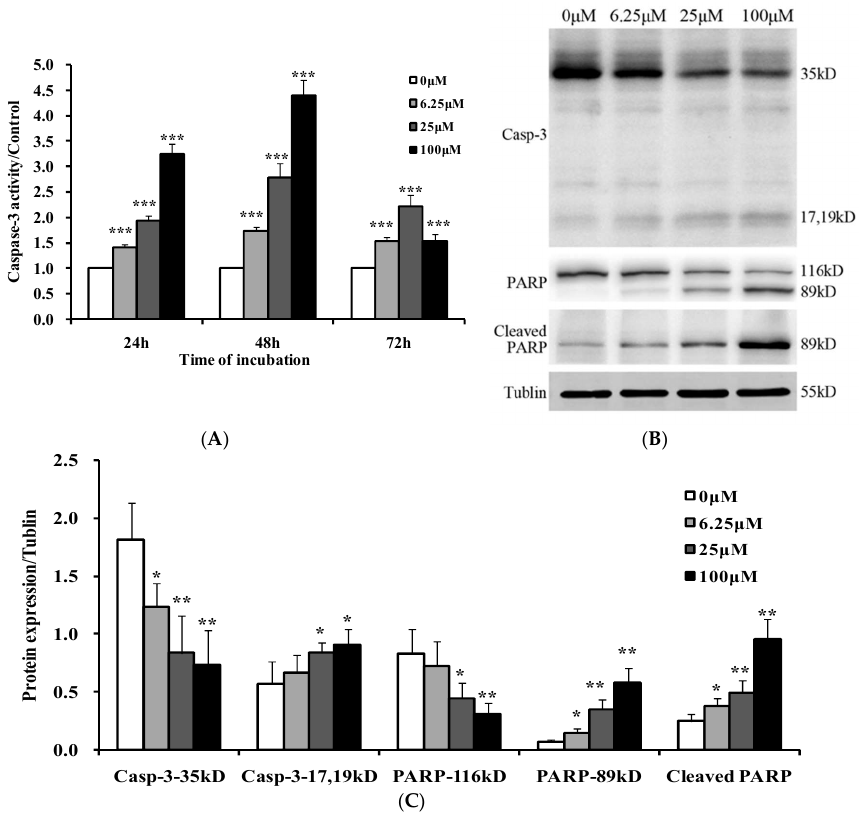
Figure 5. Effects of luteoloside on the activity of caspase-3 and the cleavage of poly (ADP-ribose) polymerase (PARP). ( A ) Cells were treated with various concentrations of luteoloside for the indicated time. The activity of caspase-3 was then determined and expressed as the fold over the control (0 μM luteoloside); ( B ) Cells were treated with the indicated concentrations of luteoloside for 24 h. The cleavage of caspase-3 and PARP were analyzed by Western blot using the specific antibodies. The level of tublin was used as an internal control. Results shown are representative of three independent experiments; ( C ) The relative expression of proteins compared with tublin. Casp-3: Caspase-3. The data are the mean ± SD of three independent experiments. * p < 0.05, ** p < 0.01, and *** p < 0.001 represent statistically significant differences versus control group (0 μM luteoloside).